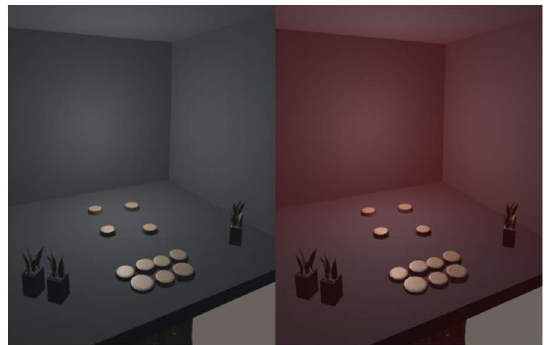
Fig. 8 Warning tint effect on Office environment